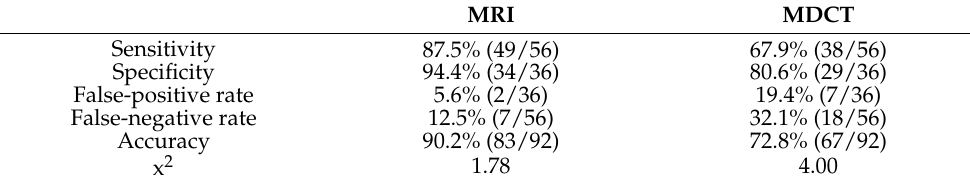
Table 3. Diagnostic performance for recurrent BCs between MRI and MDCT.